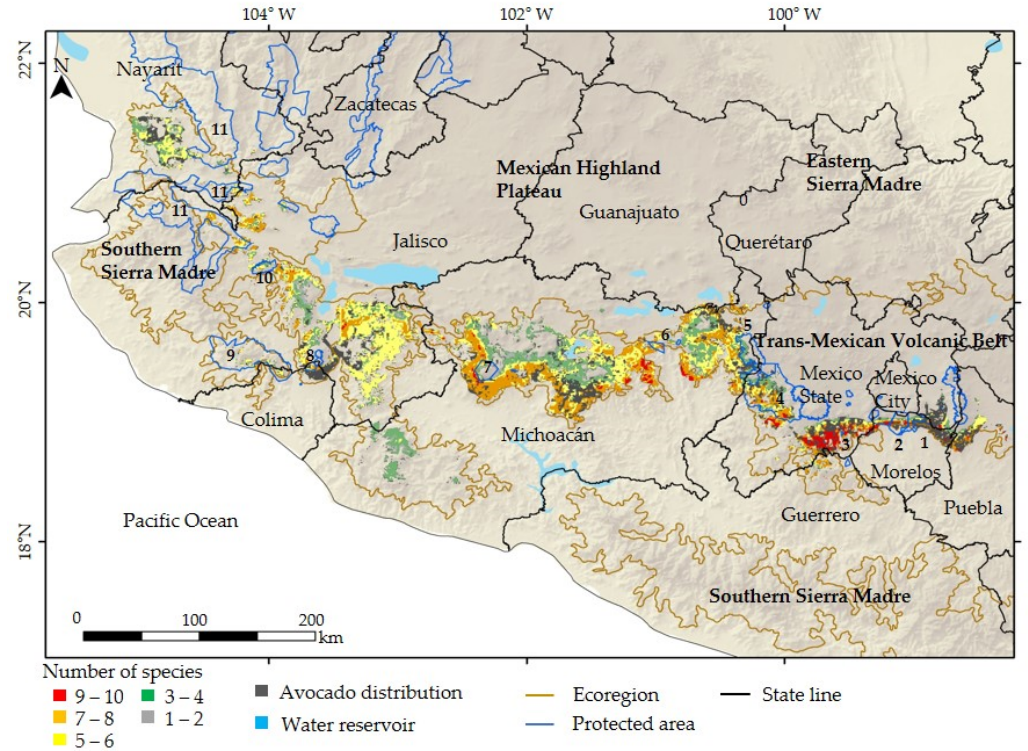
Figure 4. Number of threatened pollinator species that overlapped suitable areas for Hass avocado cultivation in Mexico. Key of protected areas: 1: El Tepozteco; 2: Biological Corridor Chichinautzin; 3: Desierto del Carmen; 4: Valley of Bravo; 5: Monarch Butterfly; 6: José María Morelos; 7: Tancítaro Peak; 8: El Jabalí; 9: Sierra of Manantlán; 10: Sierra of Quila; 11: Forest Protection Zone 043 Nayarit. Table 5. Potential extent and surface covered by protected areas according to the number of threatened pollinator species that overlapped suitable areas for avocado cultivation in